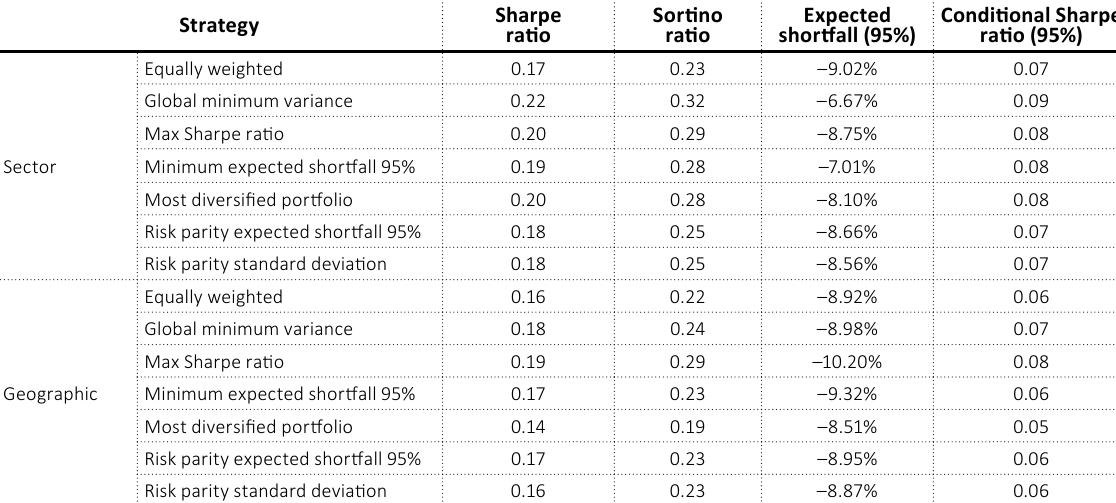
Table 8. The risk-adjusted performance of the risk-based portfolios Strategy Sharpe